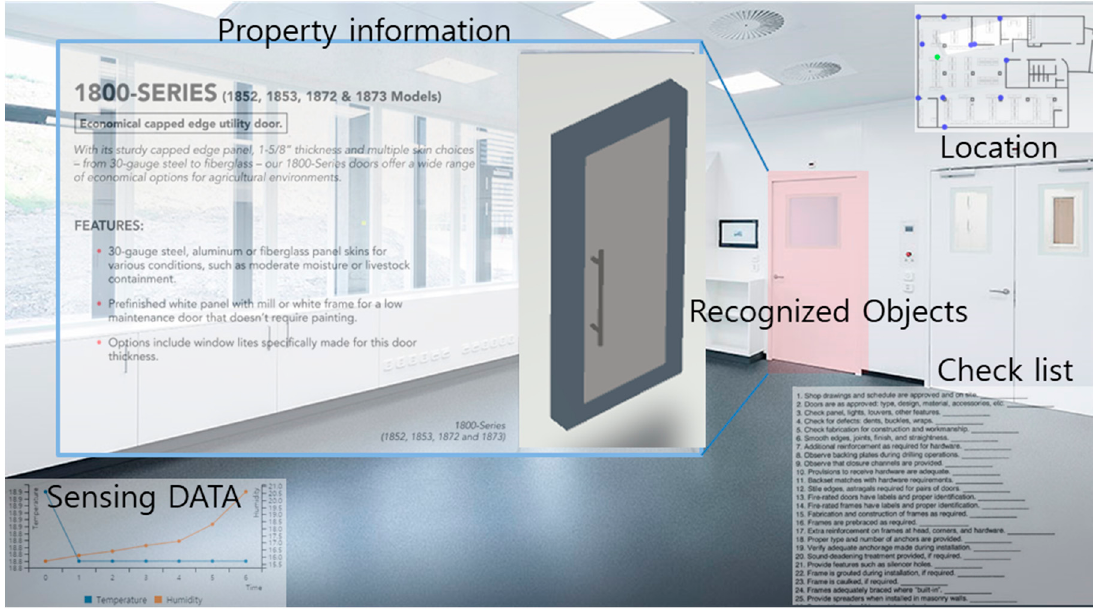
Figure 9. System’s functional display configuration.